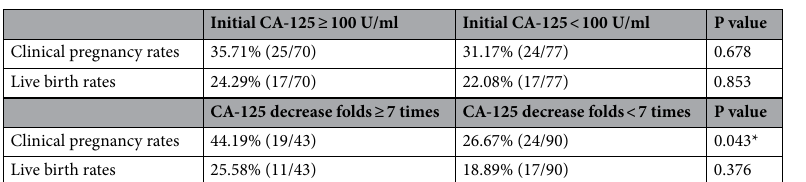
Table 3. Cumulative live birth rates per retrieval cycle of the four groups. NS non-significant P-values. Patients with embryos transferred from mixed cycles were excluded.